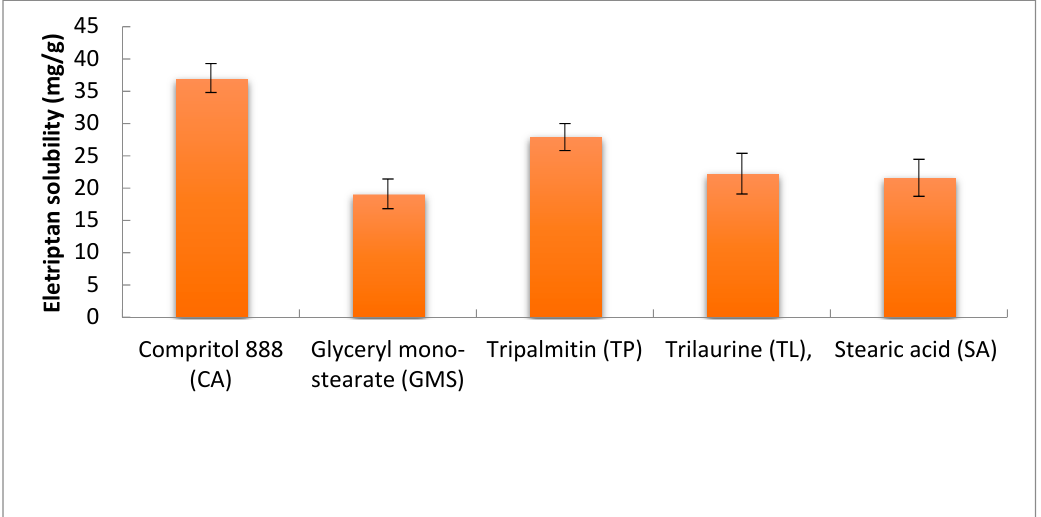
Figure 1. Solubility of EH in different solid lipids.